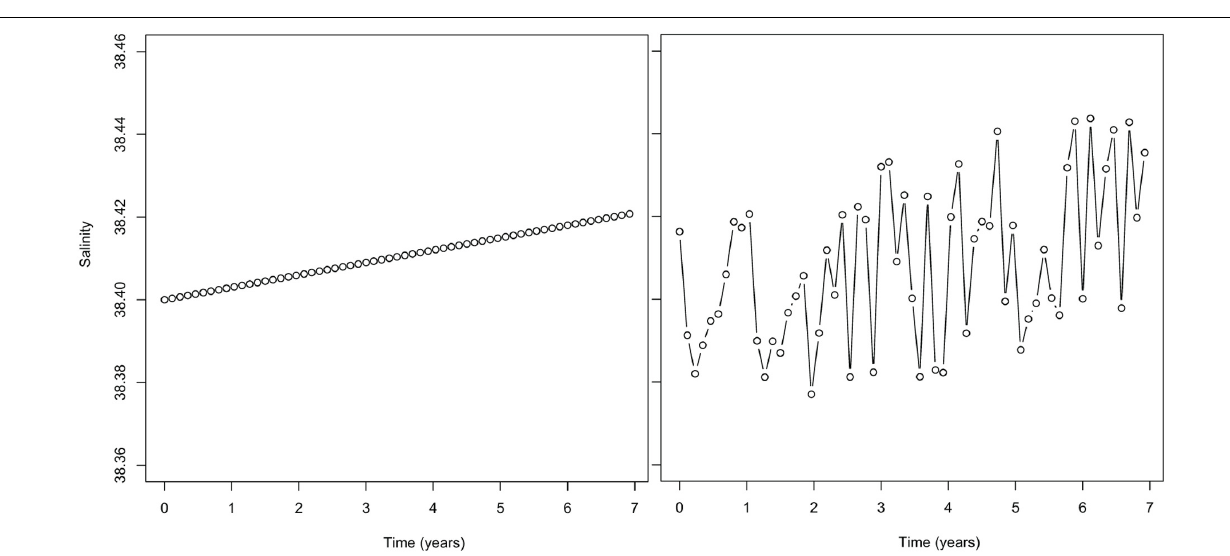
Frontiers in Marine Science |